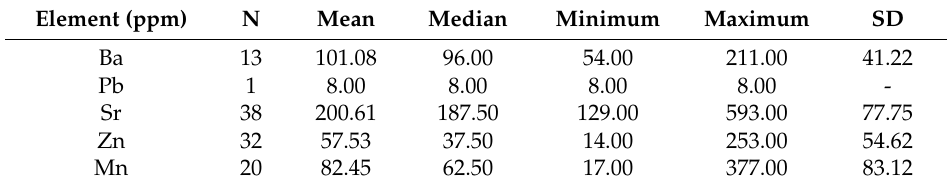
Table 1. Concentrations of the examined elements in the hard tissues (bones and teeth together) of ruminants from the Tian-Shan mountains.